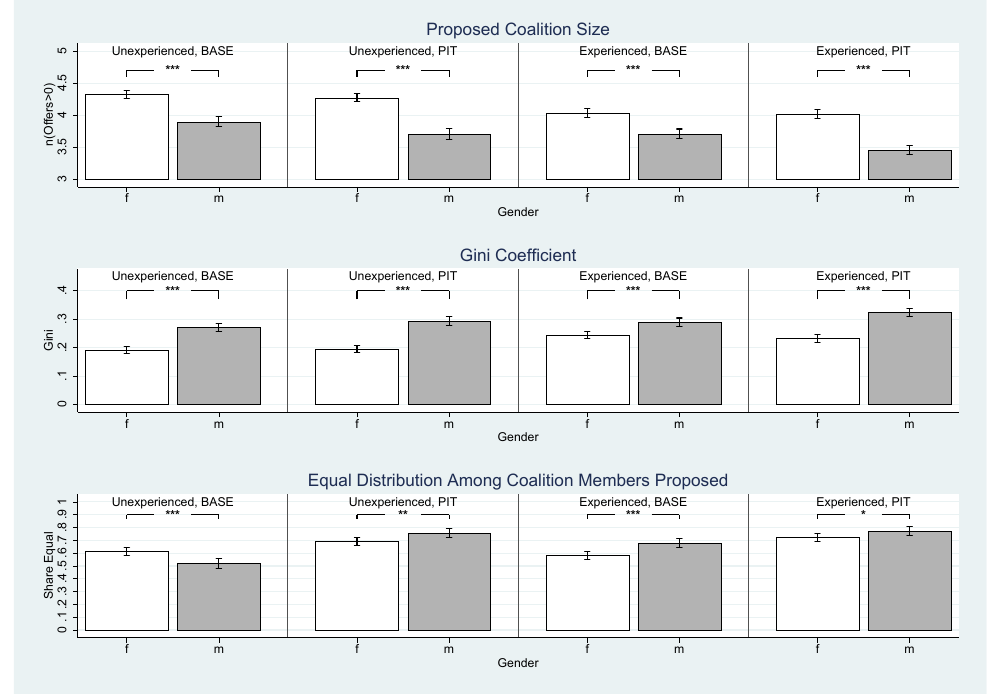
Figure 8. Proposed Coalition Size, Gini Coefficient, and Share of Equal Distributions Proposed by Experience, Treatment, and Gender. Upper panel: average proposed coalition size ( n ( Offers > 0 ) ); middle panel: Gini coefficient; lower panel: share of equal distributions among the members of the coalition proposed. The number of observations for each bar, means, and standard errors, as well as t -tests can be taken from Table A7 in Appendix A. Significance levels: * p ≤ 0.10, ** p ≤ 0.05, and *** p ≤ 0.01. Error bars represent 90% confidence